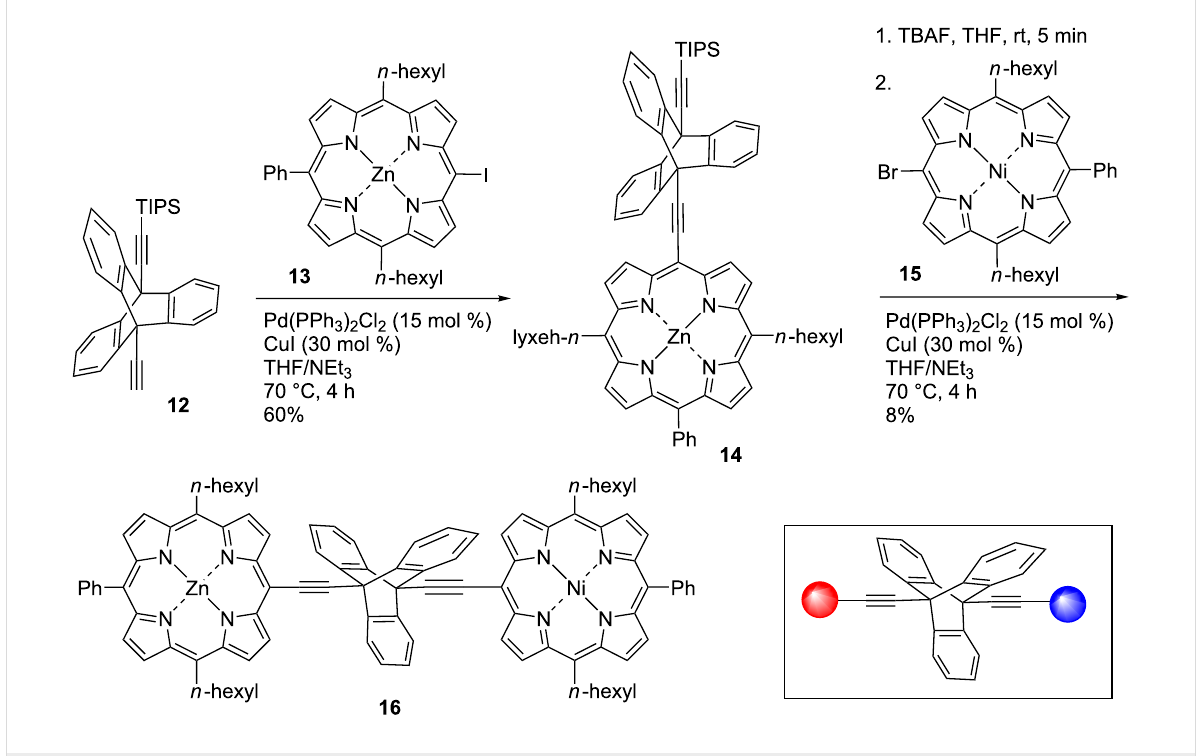
Scheme 2: Sonogashira cross-coupling reactions to form a triptycene-substituted porphyrin monomer and an unsymmetrically substituted triptycene- linked porphyrin